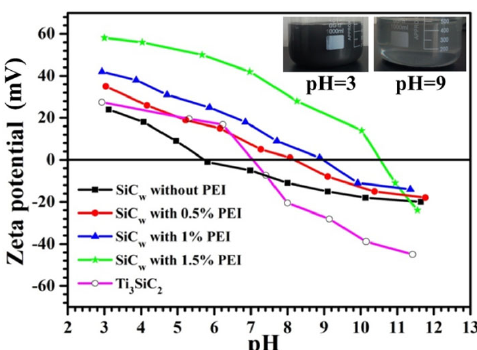
Fig. 1 Zeta potential of Ti 3 SiC 2 and SiC w with/without PEI dispersant in an aqueous system. The insets compare the image of SiC w /Ti 3 SiC 2 dispersion at pH = 3 and 9.